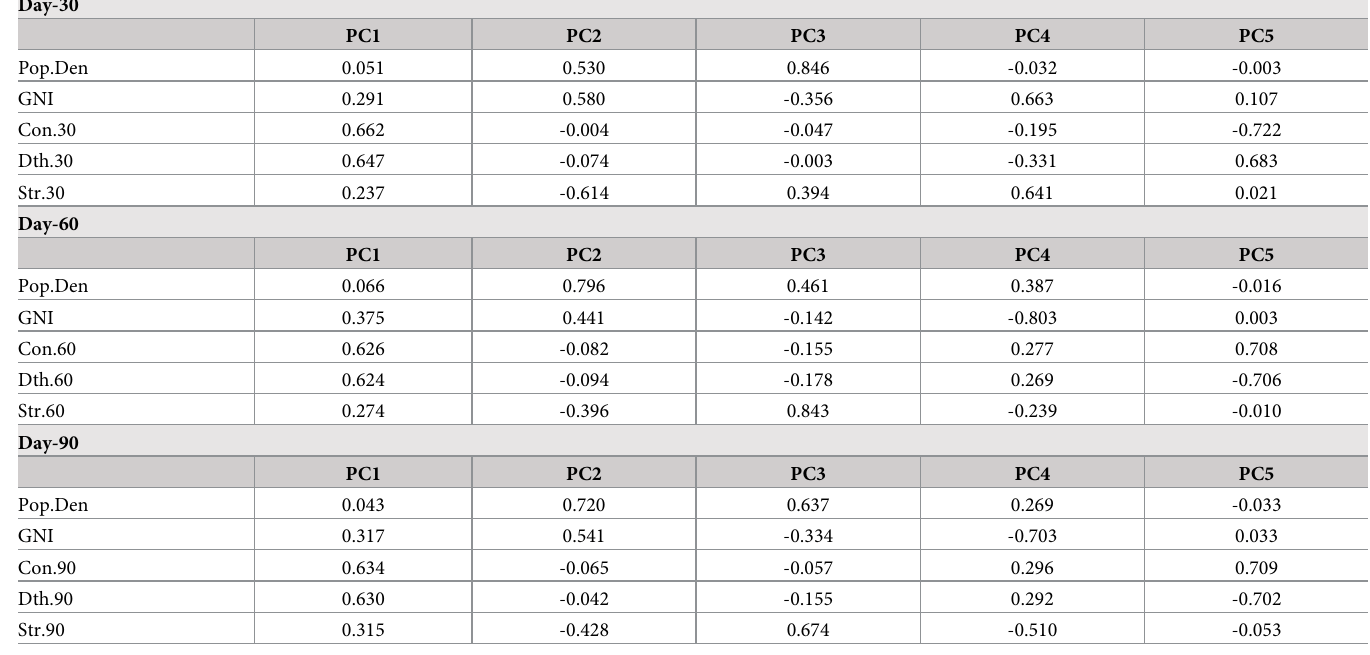
Table 3. Principal component loading vectors from PCA